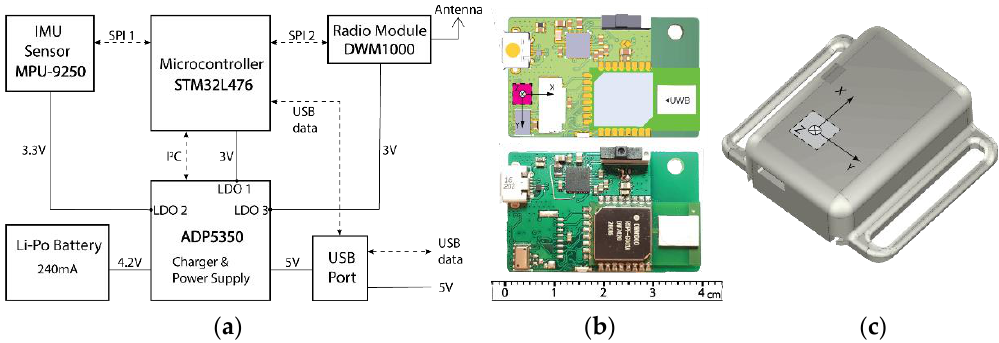
Figure 2. ( a ) IMU unit schematic diagram with microcontroller, IMU sensor, radio module, smart charger and power supply, and LiPo battery ( b ) Rendering and photograph of the device ( c ) Special 3D-printed IMU unit case.